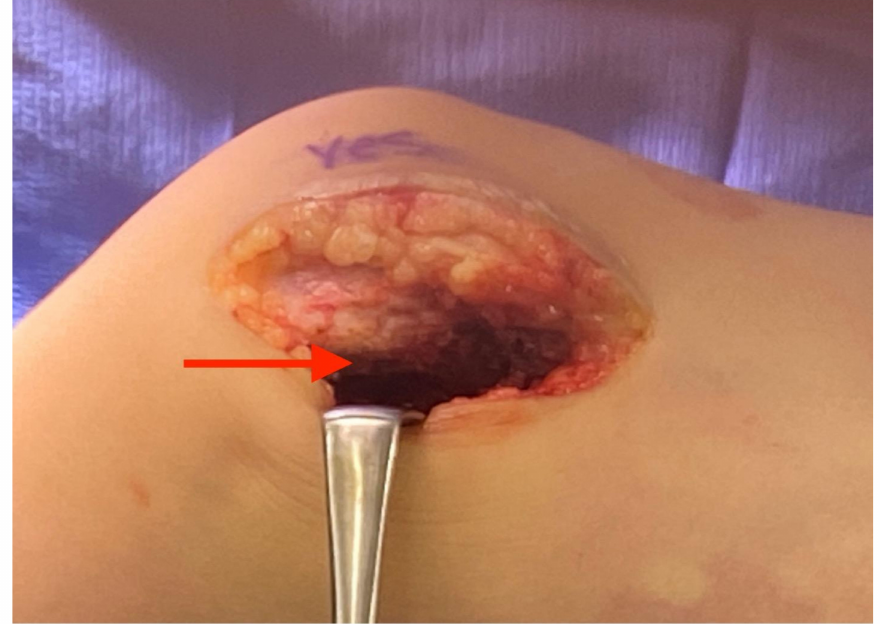
Figure 6. Medial incision with release of the postero-medial capsule of the knee. The incision is extended proximally to the subtrochanteric region and the remainder of the proximal femur is subperiosteally dissected. A wire for the appropriate, predetermined, diameter Slim™ rod (Pega Medical, QC, Canada) is inserted from the greater trochanter past the distal femoral physis. The canal is reamed to prepare for placement of the final rod. The length of the rod is determined by measuring the amount of wire in the canal (using another wire and ruler) and subtracting the presumed amount of shortening. For example, if the distance from the greater trochanter to just past the distal femoral physis measures 250 mm and you plan on shortening 50 mm then the rod length should be 200 mm. If